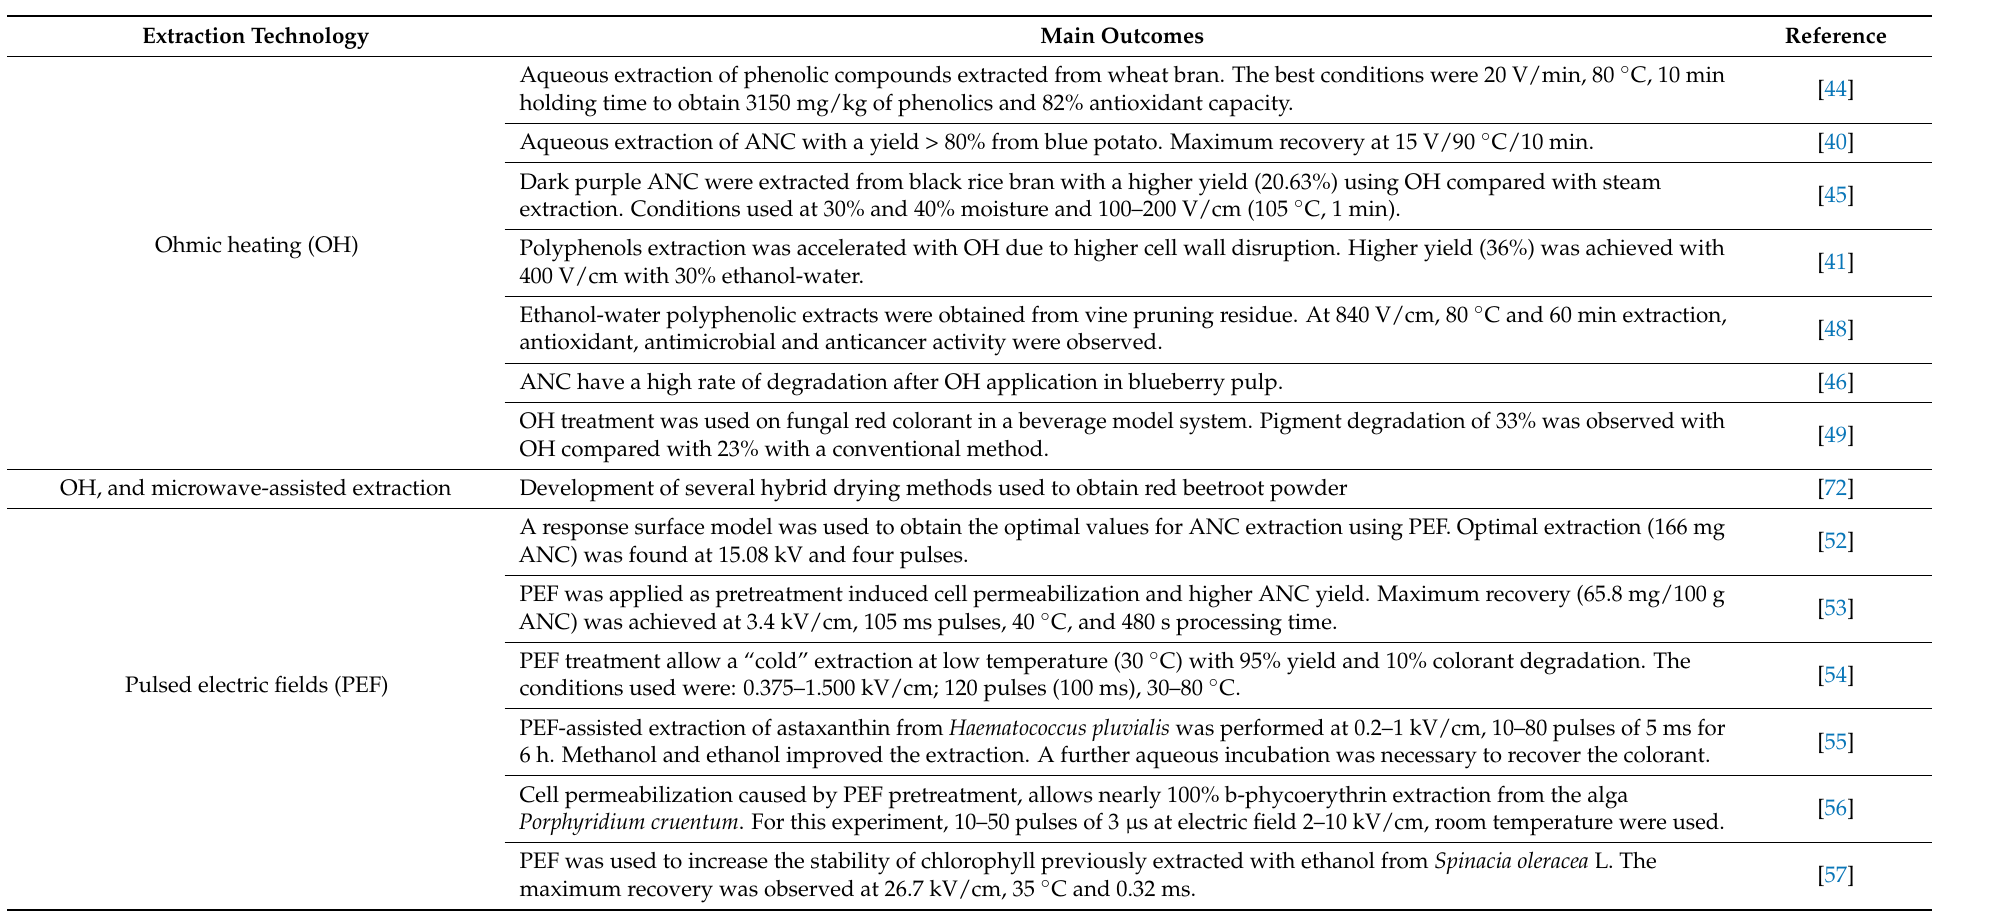
Table 1. Main outcomes from reported industrial extraction technologies of natural